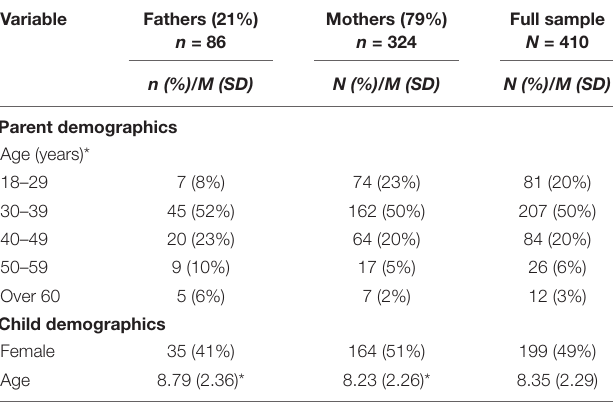
TABLE 1 | Parent and child demographics by parent